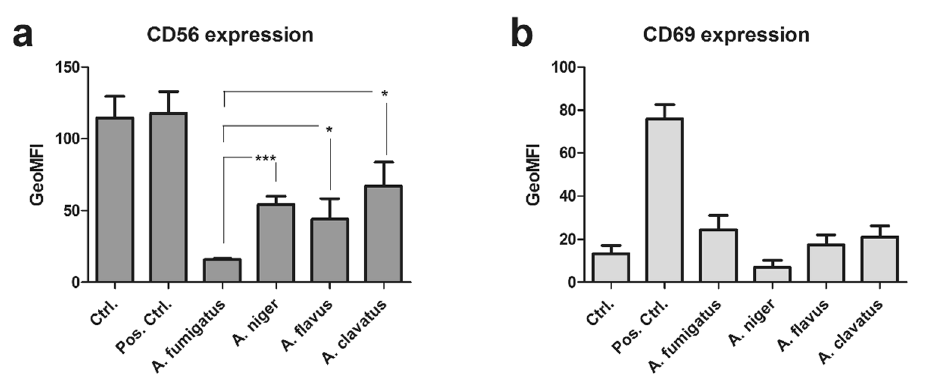
Figure 8. The reduction of CD56 is not as stringent for other Aspergillus species as it is for A. fumigatus . Primary NK cells were pre-treated overnight with IL-2 (1000 U/ml). Pre-treated NK cells were cultured in the presence of germ tubes of A . fumigatus , A . niger , A . flavus or A . clavatus at MOI 0.5, or were left untreated (Ctrl.) for 6 h. NK cells treated with 500 U/ml IL-15 and IL-2 served as control for NK cell activation (Pos. ctrl.). The expression of CD56 ( a ) and CD69 ( b ) was analysed using flow cytometry. NK cells were defined as NKp46 + CD3 − . Data are represented as mean of the geometric mean fluorescence intensity (GeoMFI) + SEM of n = 4 independent experiments. Significant differences between AF GT treated NK cells and NK cells treated with the other Aspergilli are indicated by an asterisk ( * p < 0.05; ** p < 0.01; *** p < 0.005; **** p <